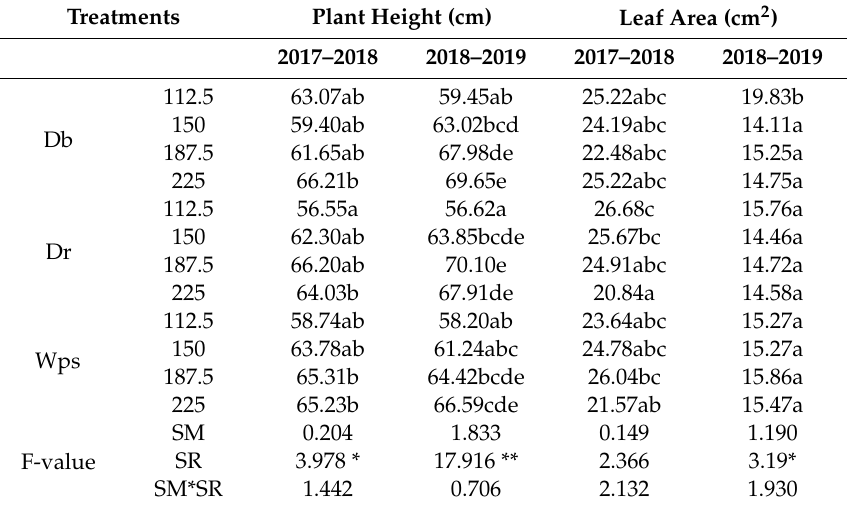
Table 5. The plant height and leaf area means a ff ected by the sowing methods (SM) and seed rate (SR) at the flowering